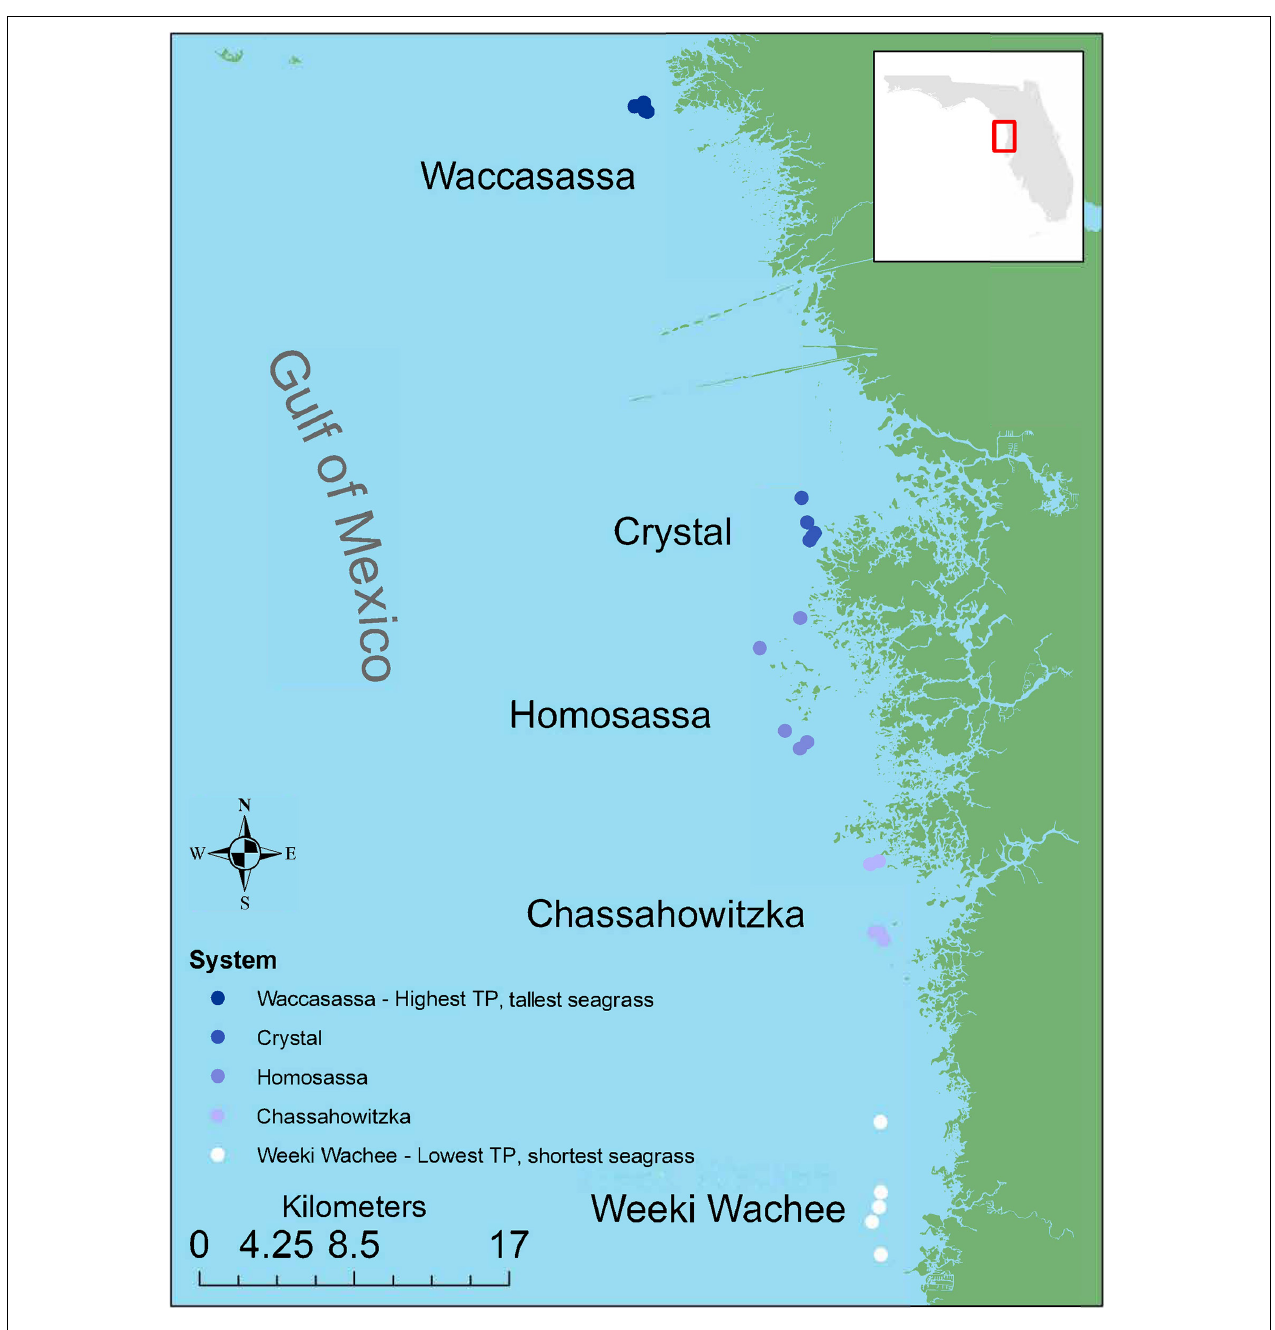
FIGURE 1 | Study region and benthic invertebrate sampling stations. Colors indicate relative levels of long-term total phosphorus (TP) concentrations in the water column, with lighter colors indicating lower